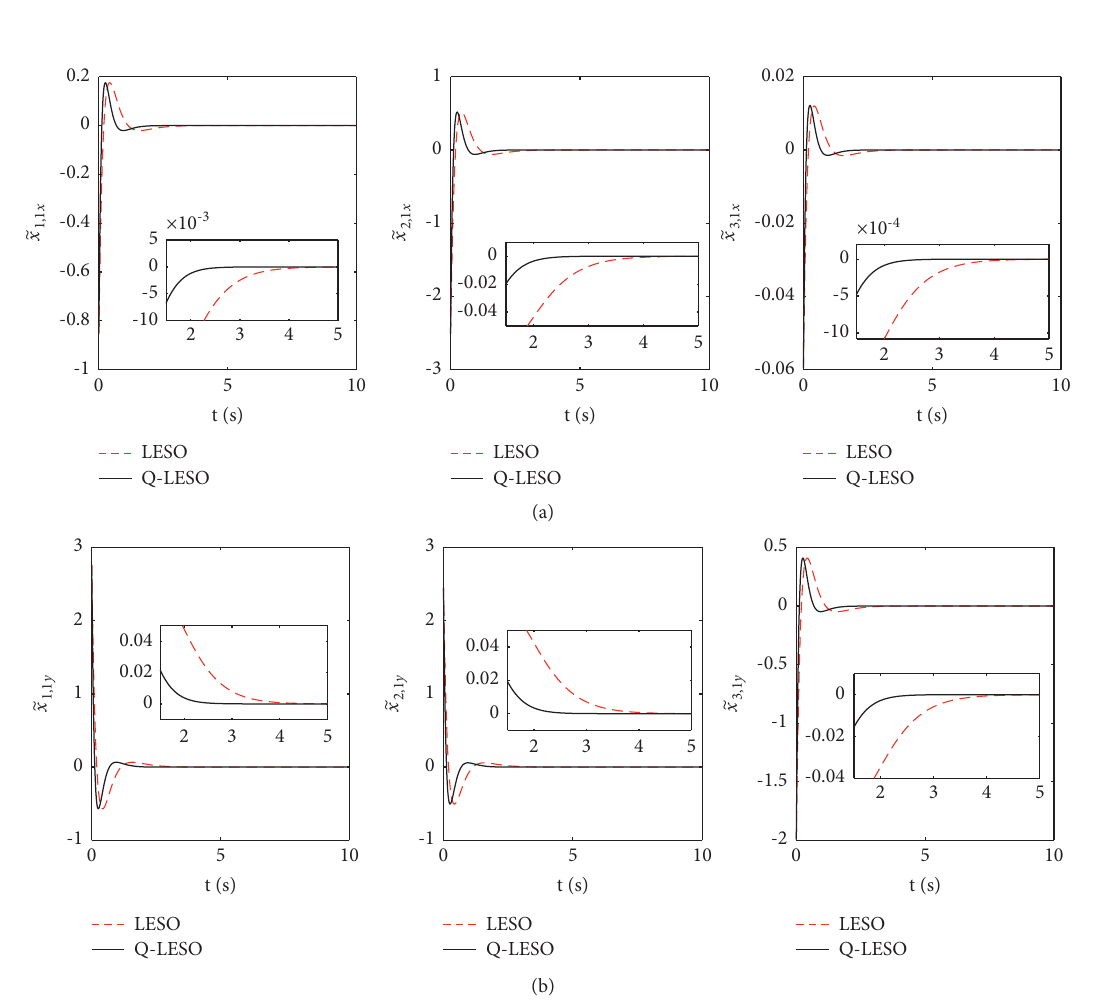
Figure 3: The position estimation error 􏽥 x i, 1 in Case A. (a) The position estimation error of the x -direction of the i th agent i position estimation error of the y -direction of the i th agent i � 1, 2,